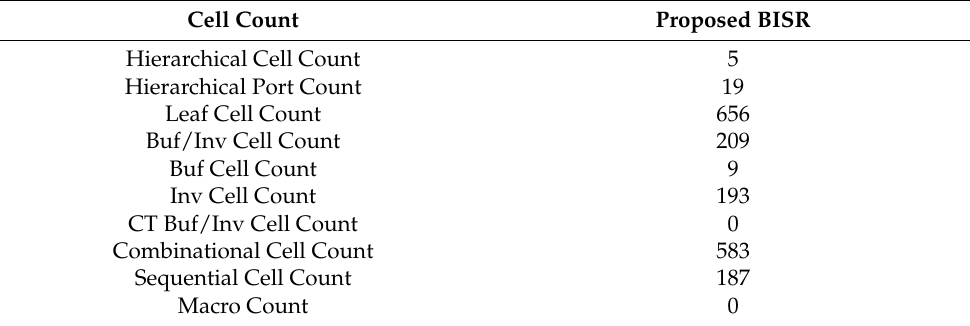
Table 8. ASIC area report of the proposed